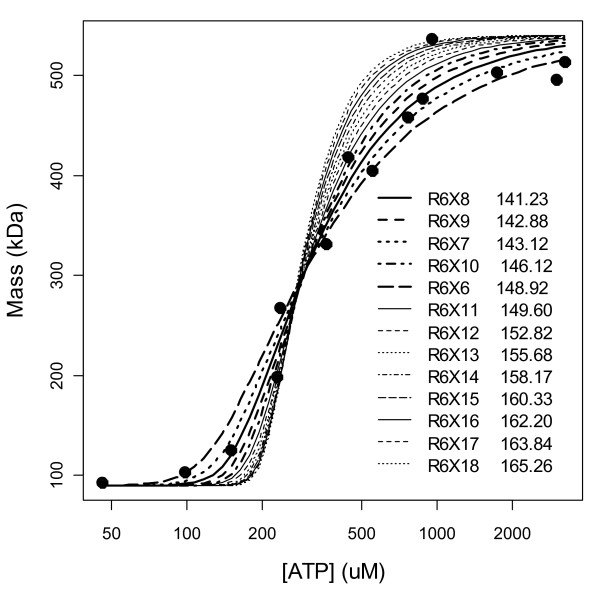
Fits of the 1-parameter models. The legend in the plot indicates the model order ranked by AICs (values shown). The top 5 models are indicated by thicker lines. Beyond 5 or more a-sites occupied by ATP and with increasing numbers of h-sites occupied, the fits become worse and worse.